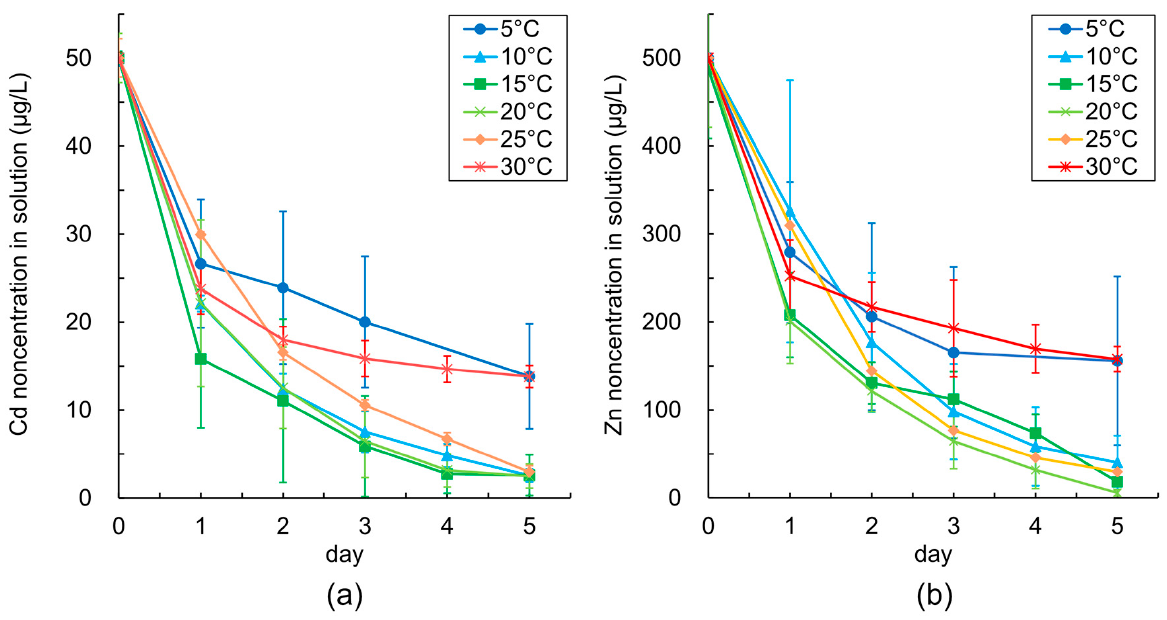
Figure 4. Changes in the ( a ) Cd concentrations and ( b ) Zn concentrations in the solutions under di ff erent temperatures.